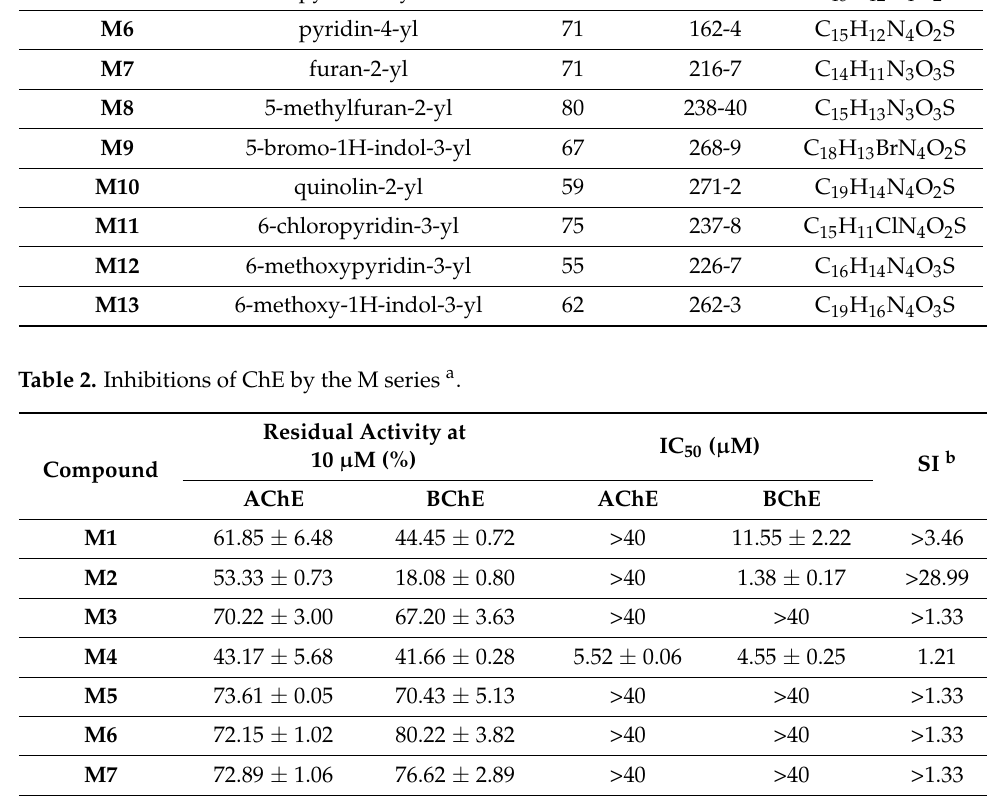
Table 2. Inhibitions of ChE by the M series a .